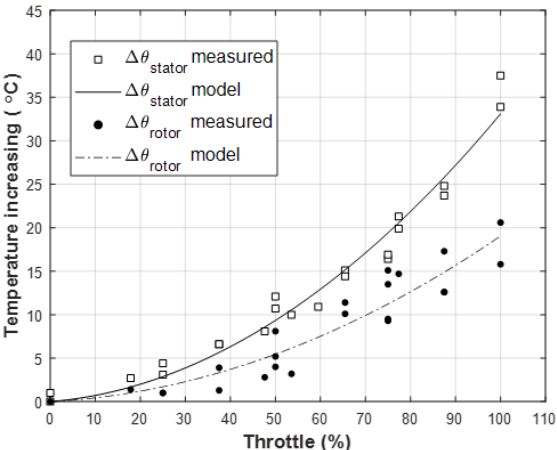
Figure 22. Thermal profile for sample motors during the static thrust tests according to throttle